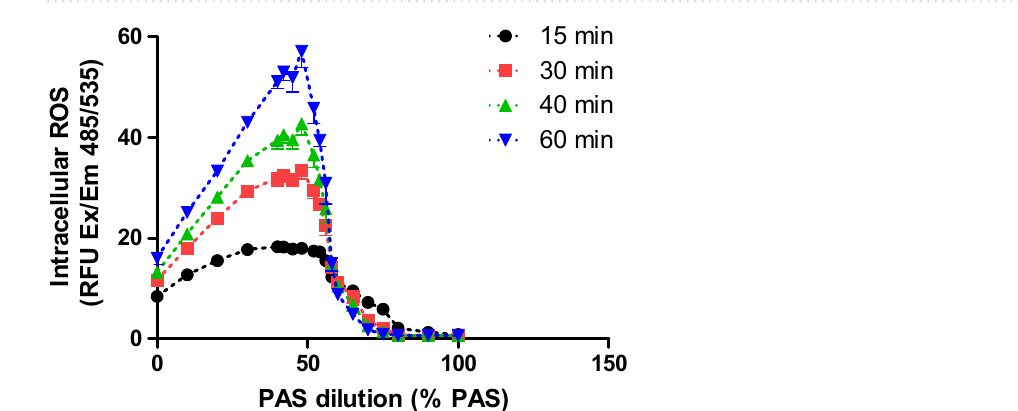
Figure 10. Mitochondrial membrane potential after incubation with PAS 20 for different contact times: ( A ) after 15 min, ( B ) 30 min, ( C ) 40 min, ( D ) 60 min contact time. Graphs represent averages of three independent PAS treatments.